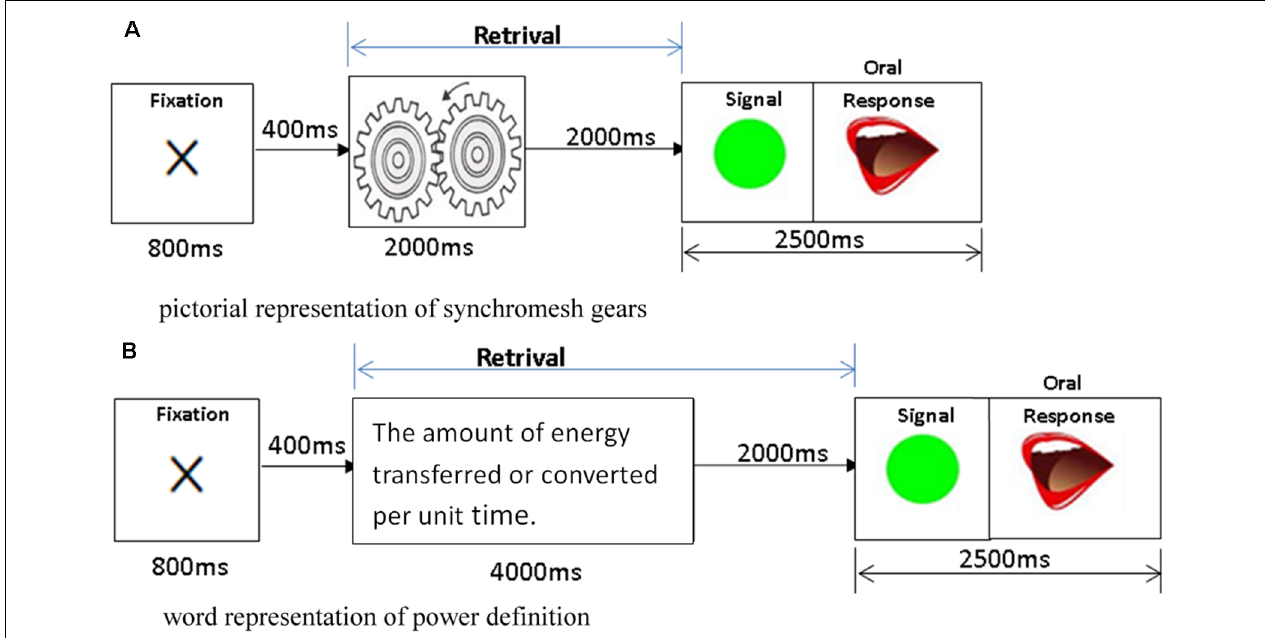
FIGURE 1 | The retrieval stimuli of physics concepts are presented in the picture and word modalities. (A) Sample trial of synchromesh gears is presented in picture for 2,000 ms, followed by a 2,000-ms blank for the participants to retrieve the concept, and then make a verbal response as soon as they see a “go” signal. (B) Sample trial of the definition of power is presented in word (text) for 4,000 ms, followed by a 2,000-ms blank for the participants to retrieve the concept, and then make a verbal response as soon as they see a “go” signal.